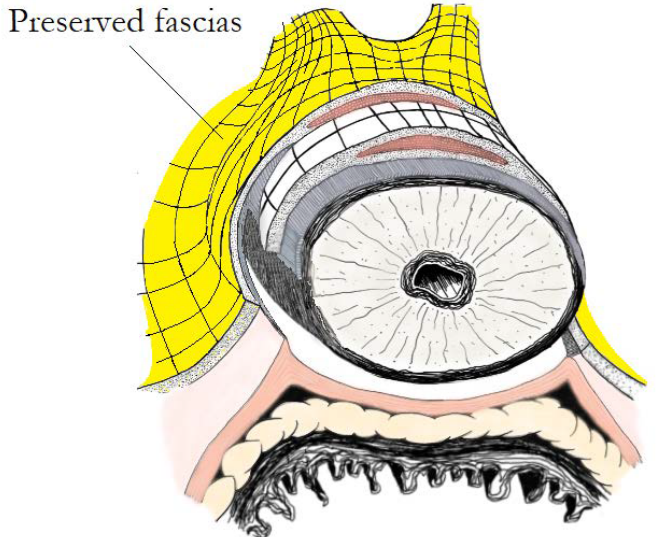
Figure 5. Super Veil of Aphrodite technique: a fascial plane between prostatic pseudocapsule and anterolateral periprostatic tissue is developed in the apical area. Preserved fascias (including part of puboprostatic ligaments-detrusor apron and part of anterolateral endopelvic and prostatic fascias) are highlighted in yellow.